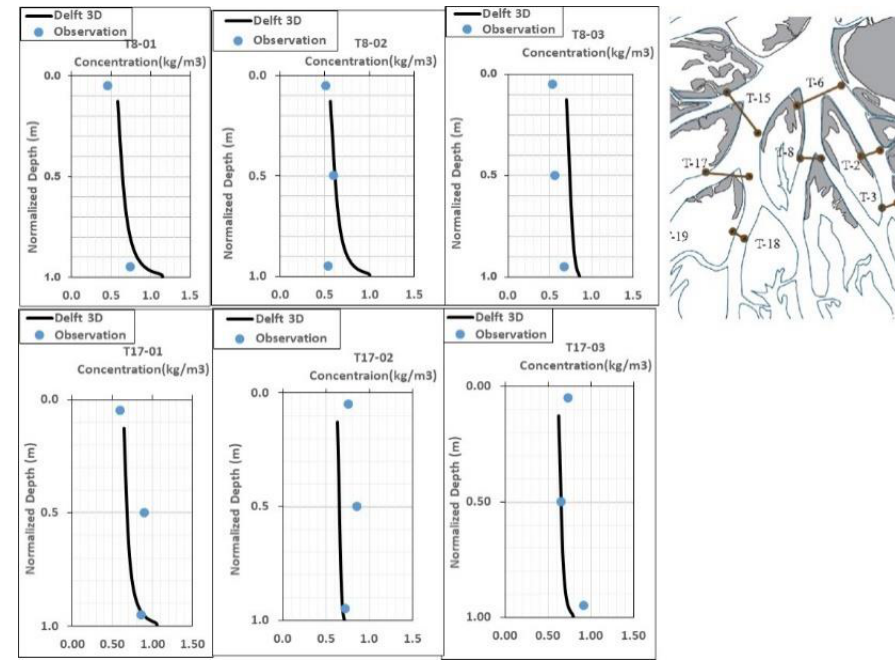
Figure 8. Validation results for total suspended vertical profiles at select transects.